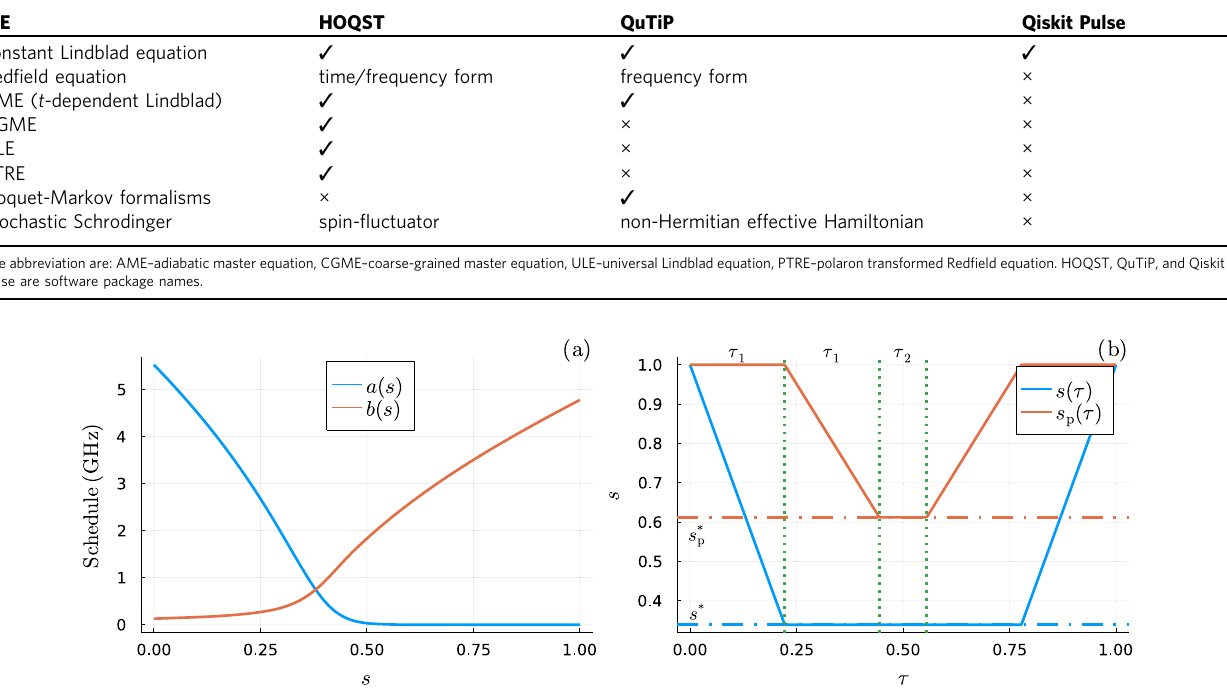
Fig. 1 Annealing schedules and annealing parameters. In ( a ), we show the typical annealing schedules for the D-Wave device. In ( b ), we show the annealing parameters s ( τ ) and s p ( τ ) (see Eq. (22)) used in the entanglement witness experiment. There are three stages in the experiment: i. fi rst evolve s ( τ ) from 1 to s ∗ for τ ∈ [0, τ 1 ] and then evolve s p ( τ ) from 1 to s (cid:6) for τ ∈ [ τ 1 , 2 τ 1 ]; ii. pause for a time τ 2 ; iii. reverse the fi rst stage. In our simulation, p